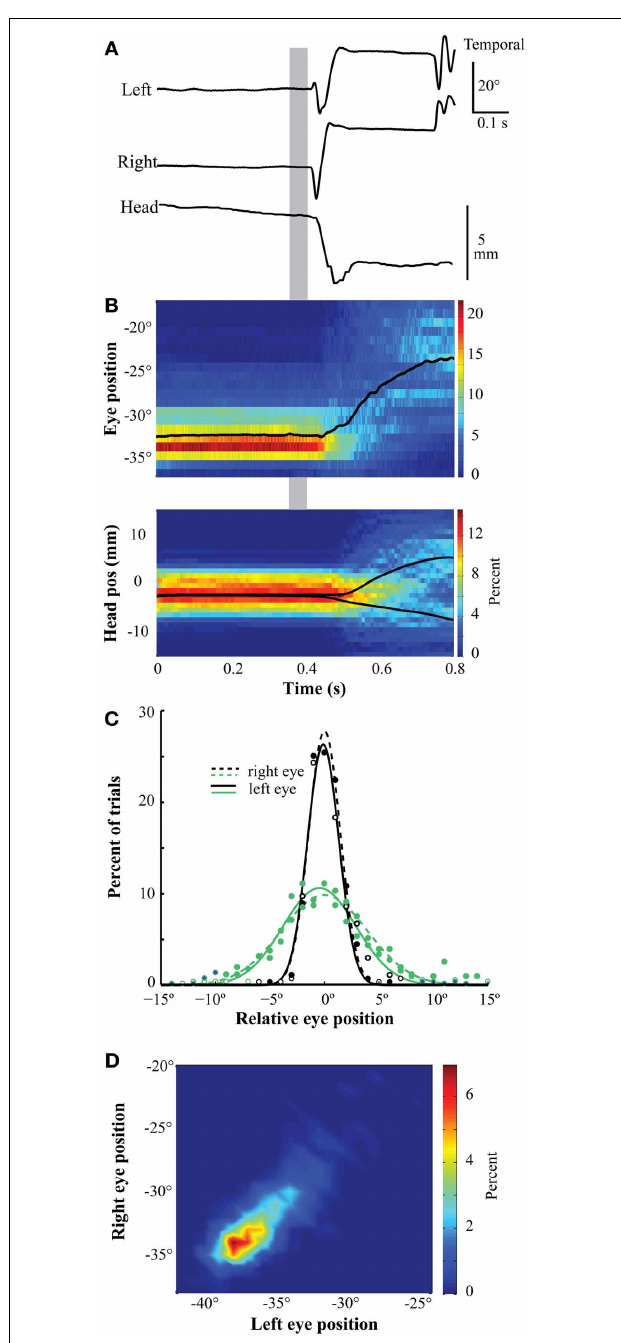
FIGURE 5 | Eye position during gaze fixation task. (A) Representative traces of left eye, right eye, and head position during fixation and orientation. The positions are stable throughout the fixation period. Following stimulus presentation (gray bar), the eyes make a divergent saccade followed by a head orienting response to the left. (B) Eye position (upper panel) and head mediolateral position (lower panel) during a session were stable and stereotyped during fixation. At each time bin (0.61ms for the eye and 8ms for the head), the distribution of positions is represented with a heat map indicating the percentage of trials in which the eye or head was at that position ( n = 657). The bin width is 1 ◦ for the eyes and